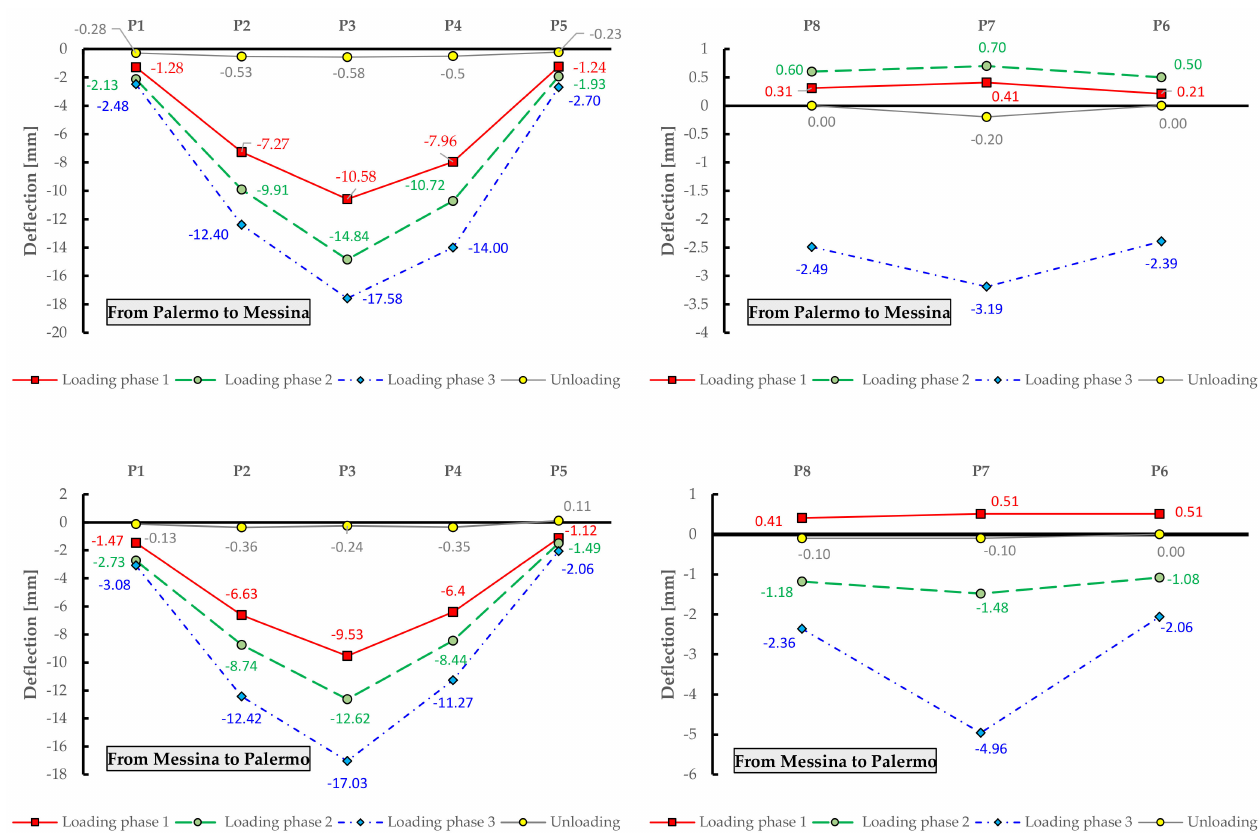
Figure 15. Experimental deflections for each measurement point obtained from static load tests on Longano bridge deck. Table 5. List of identified natural frequencies from OMA after static load tests (to compare with results from Table 1). Excitation